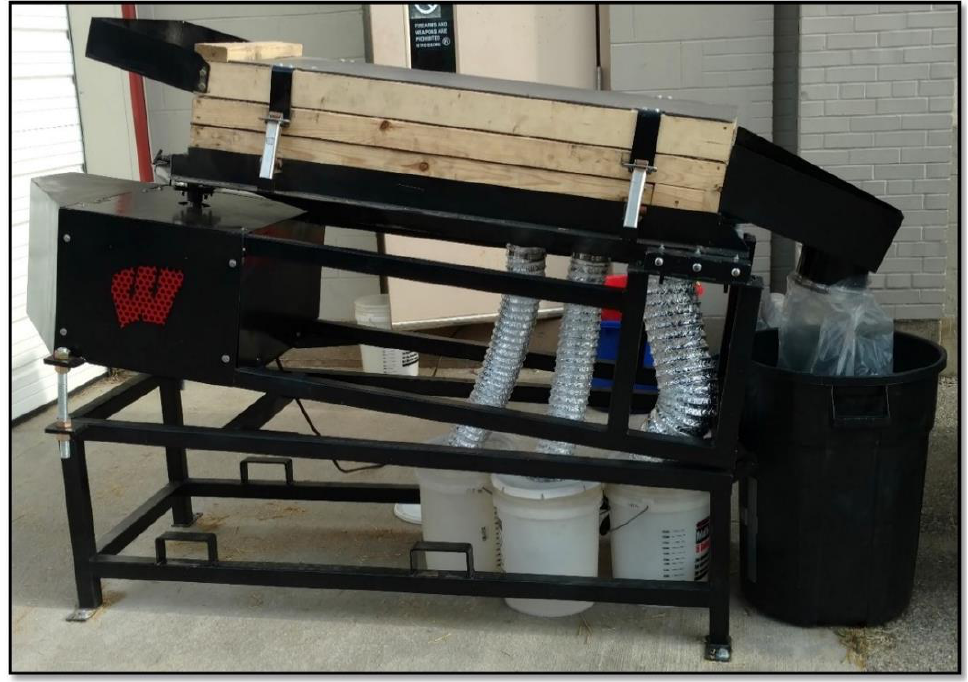
Figure 3. The gyratory screener with the fraction collection containers.